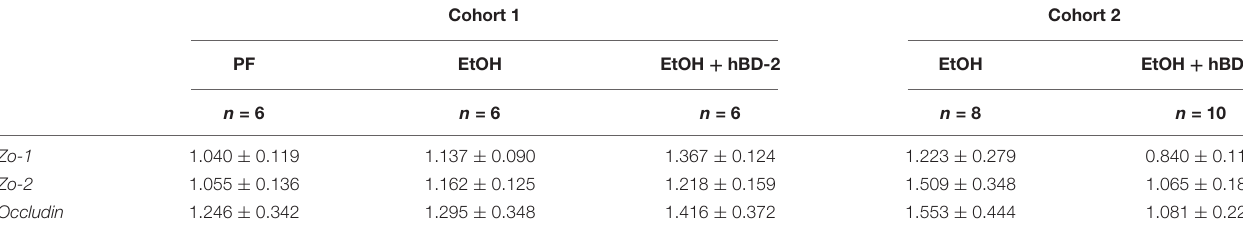
FIGURE 3 | Human beta defensin 2 ameliorated liver injury in Cohort 2. (A) ALT activity levels. (B–E) Representative digital micrographs of H&E-stained liver sections, ORO-stained liver sections, TUNEL-stained liver sections, and CAE-stained liver sections with quantitation of ORO+ area, TUNEL+ cells, and CAE+ neutrophils shown to the right of each set of images, respectively. H&E images were captured at 100 × magnification; all other images were captured at 200 × magnification. Scale bar represents 100 µ m in each panel. Data are reported as mean ± standard error of the mean. * p < 0.05. TABLE 3 | Small intestine mRNA expression of tight junction proteins in PF or EtOH-fed control or hBD-2-treated mice.